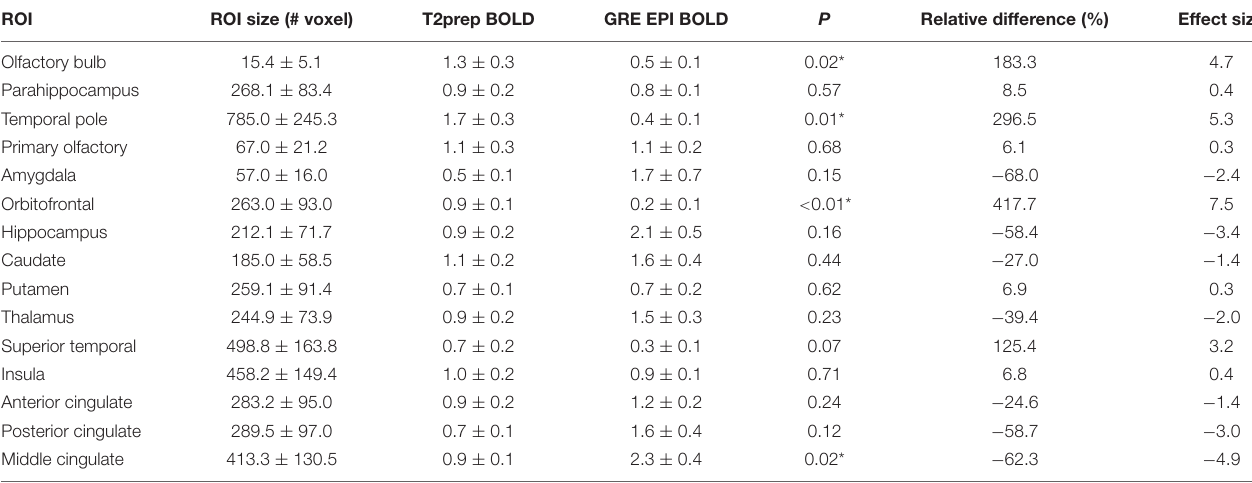
TABLE 1 | Comparison of contrast-to-noise ratio (CNR) between T2prep BOLD and GRE EPI BOLD fMRI ( n = 5). ROI ROI size (# voxel) T2prep BOLD GRE EPI BOLD P Relative difference (%) Effect